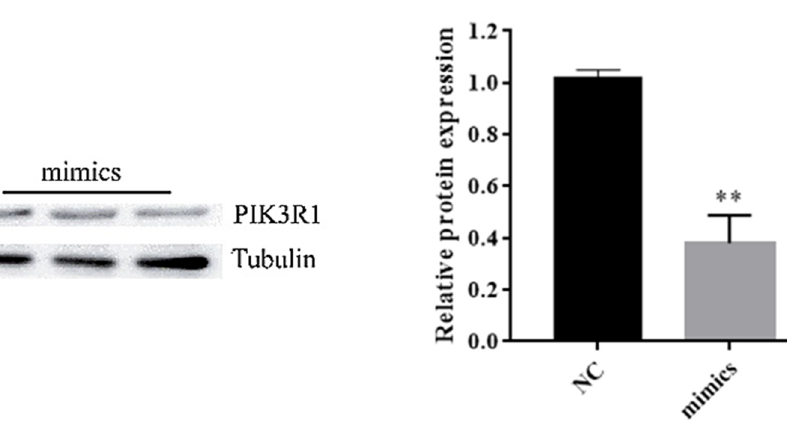
Figure 5. The overexpression of miR-F4-C12 repressed the protein expression of PIK3R1 in 3T3-L1 cells. Western blotting showed decreased protein expression of PIK3R1 in 3T3-L1 cells treated with miR-F4-C12 mimic compared to those treated with negative control miRNA (NC). Data are means ± SD. ** Indicates p < 0.01. Original western blot figures in Figures S2 and S3.